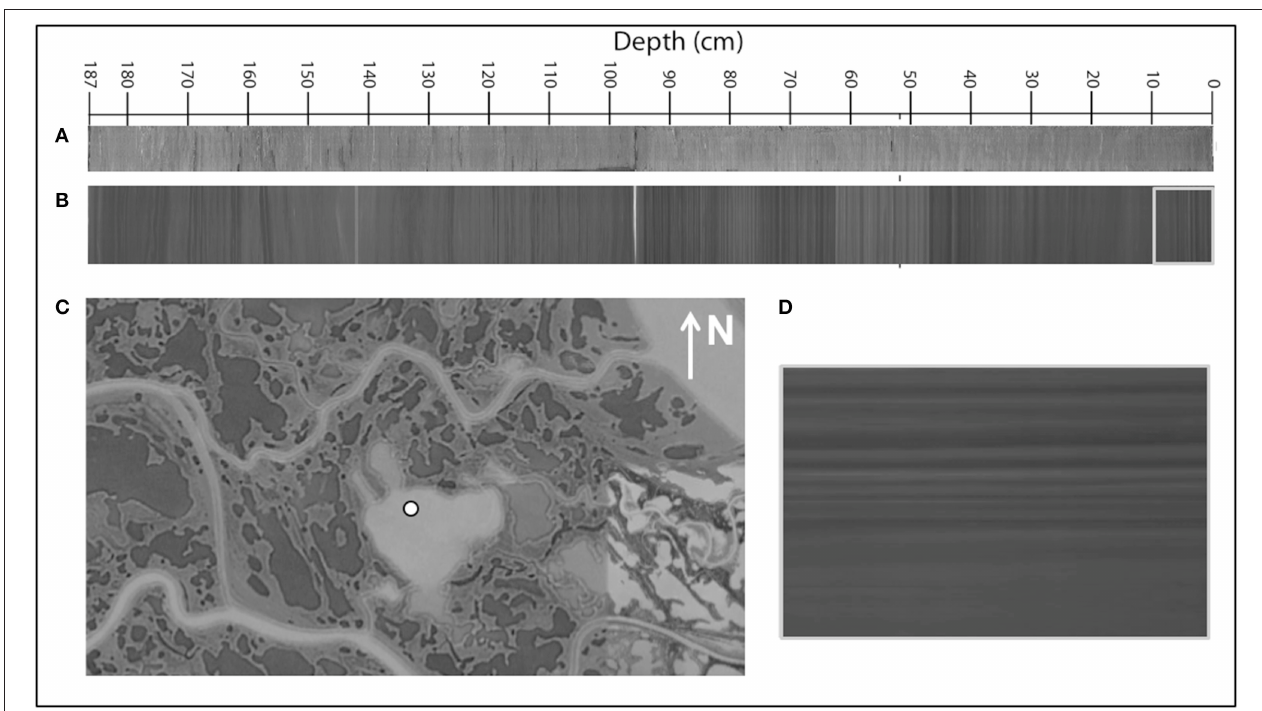
FIGURE 3 | Sediment core (A) optical image and (B) radiograph, and (C) aerial photograph of Lake LD-1 (Google Earth, 2010). The sediment core shown was collected in 2009. The white point in (C) shows the coring location. The gray box (D) shows a close-up of the radiograph in (B) (rotated 90 ◦ ), which is 10 cm in height. It clearly shows thick, fully-developed dense lamina (dark layers) overlain by less dense layers (light layers) containing thin denser